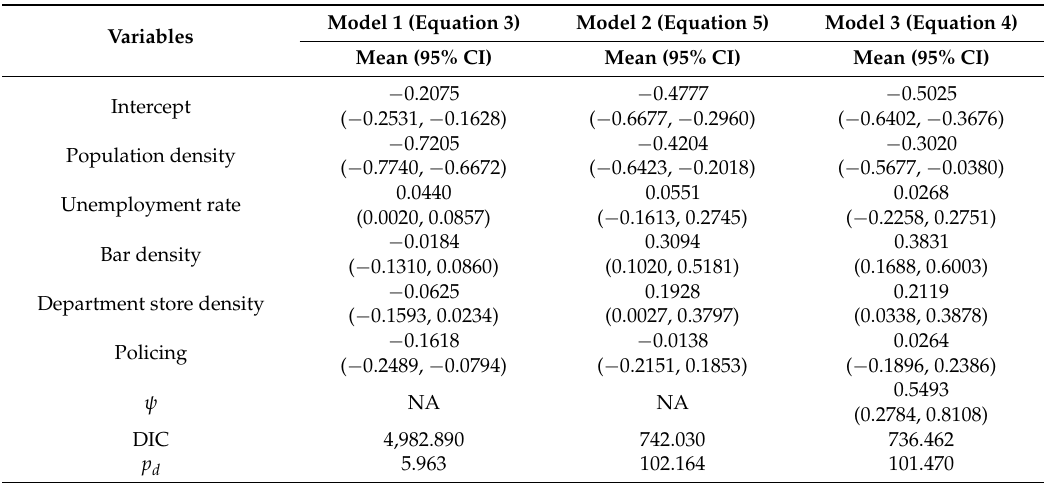
Figure 1. ( a ) History Plot; ( b ) Posterior density plot; ( c ) Gelman Rubin statistic plot; ( d ) Autocorrelation plot; ( e ) Monte Carlo (MC) error statistics for the regression parameter β 3 . Table 2. Results of the three models implemented using the WinBUGS software. CI: credible interval; DIC: deviance information criterion.